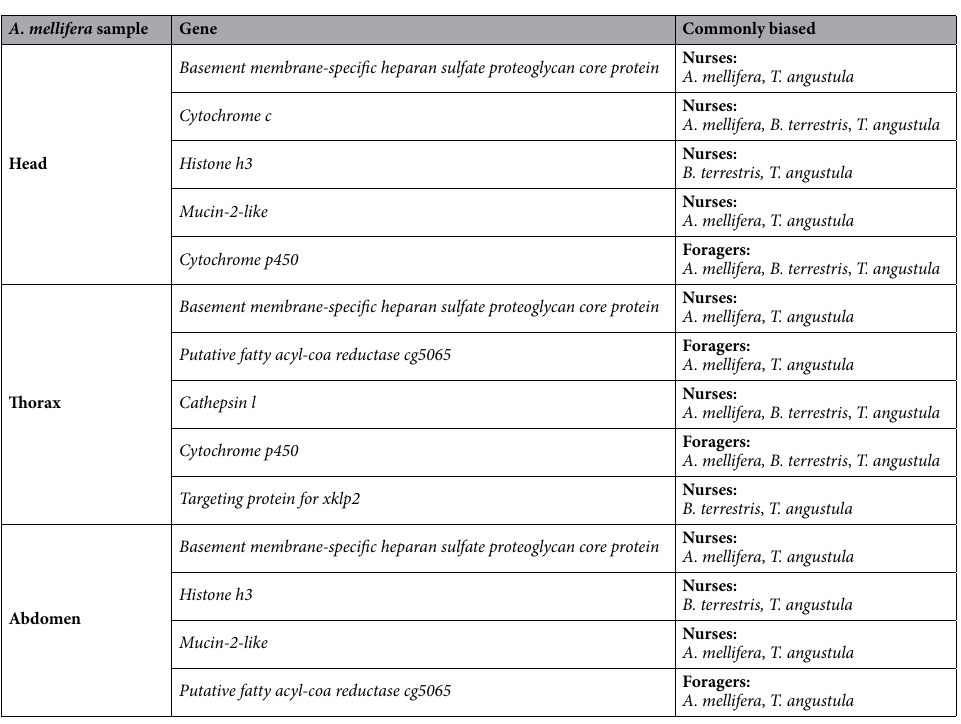
Table 2. Genes differentially expressed between nurses and foragers common across all the three